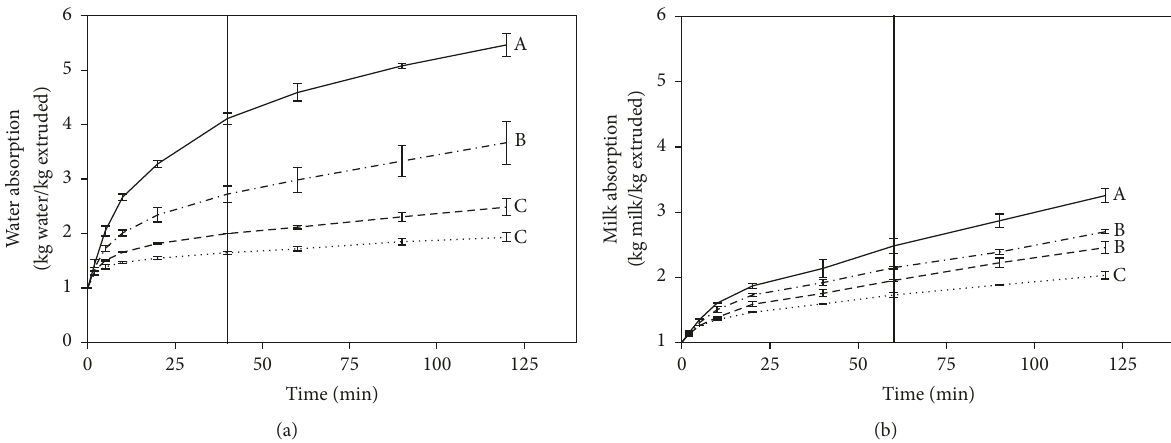
Figure 2: Absorption kinetics of: (a) water and (b) milk, of extruded cereals pigmented with —0%, – ⋅ –2.5%, ---5.0%, and ⋅⋅⋅ 7.5% of encapsulated powder of red cactus pear; different upper case letter indicates significant difference (𝑃 < 0.05) between kinetics in the same medium. Small letter indicates significant difference (𝑃 < 0.05) between water and milk